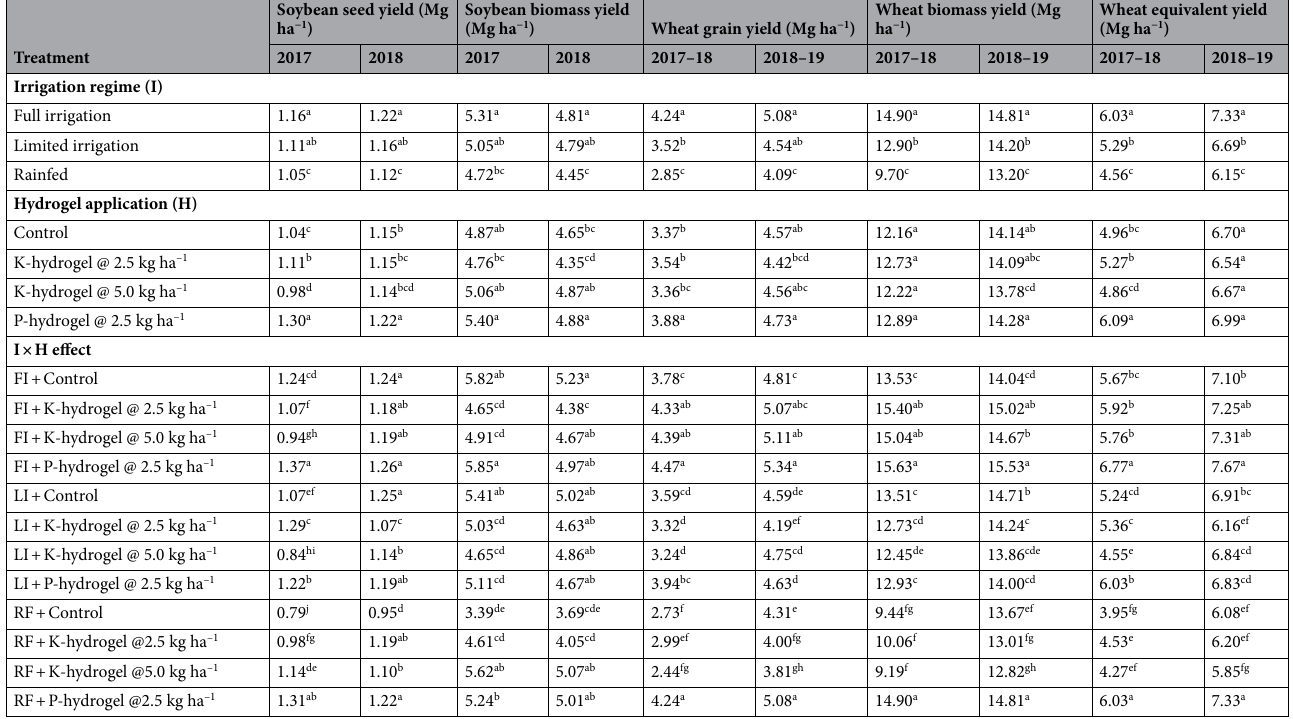
Table 1. Effect of hydrogels and moisture stress conditions on yield of soybean and wheat during 2017–2018 and 2018–2019. Means followed by a similar superscript letter within a column are not significantly different (at P ≤ 0.05) between treatments allowing to least significant difference test. Superscripts denotes the superior of the treatments i.e. a denotes best treatment followed by next best treatment b and so on. FI full irrigation, LI limited irrigation, RF rainfed; gel,